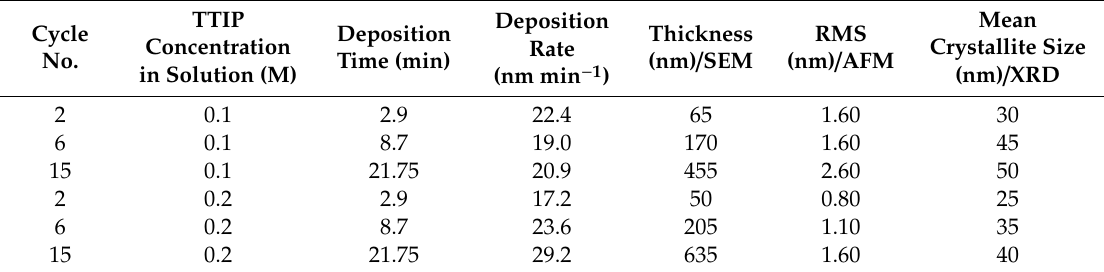
Table 1. Summary of the morphological and structural properties of TiO 2 thin